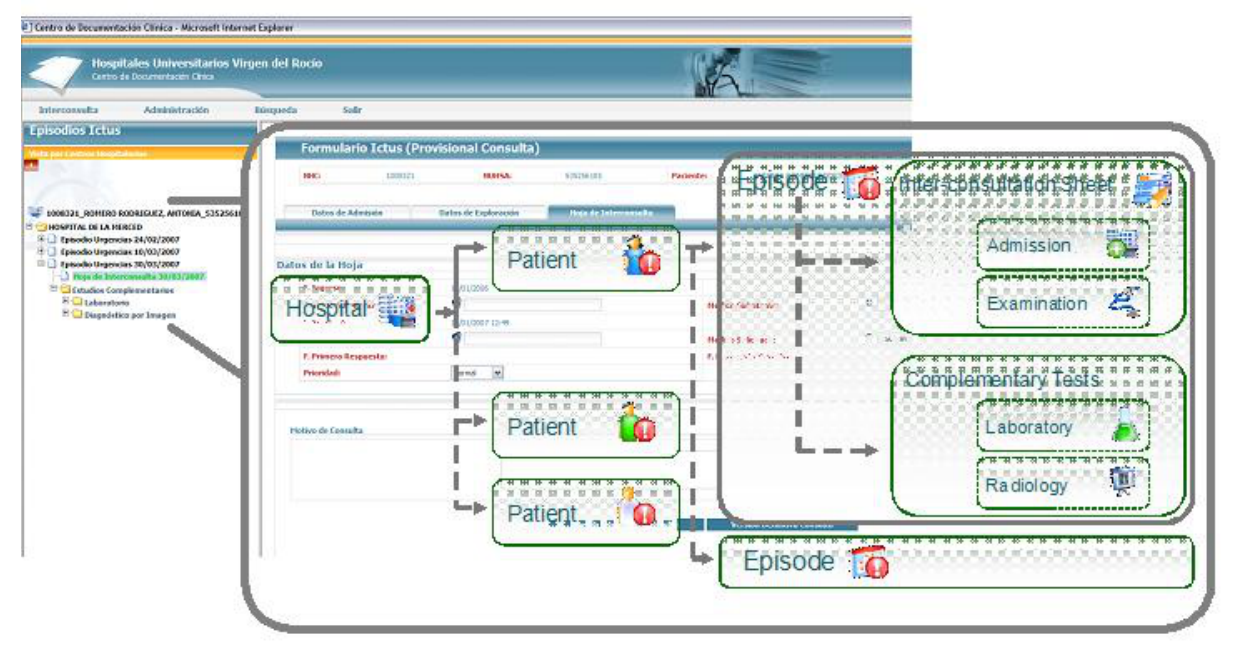
Figure 1. Data hierarchy from TeleStroke medical